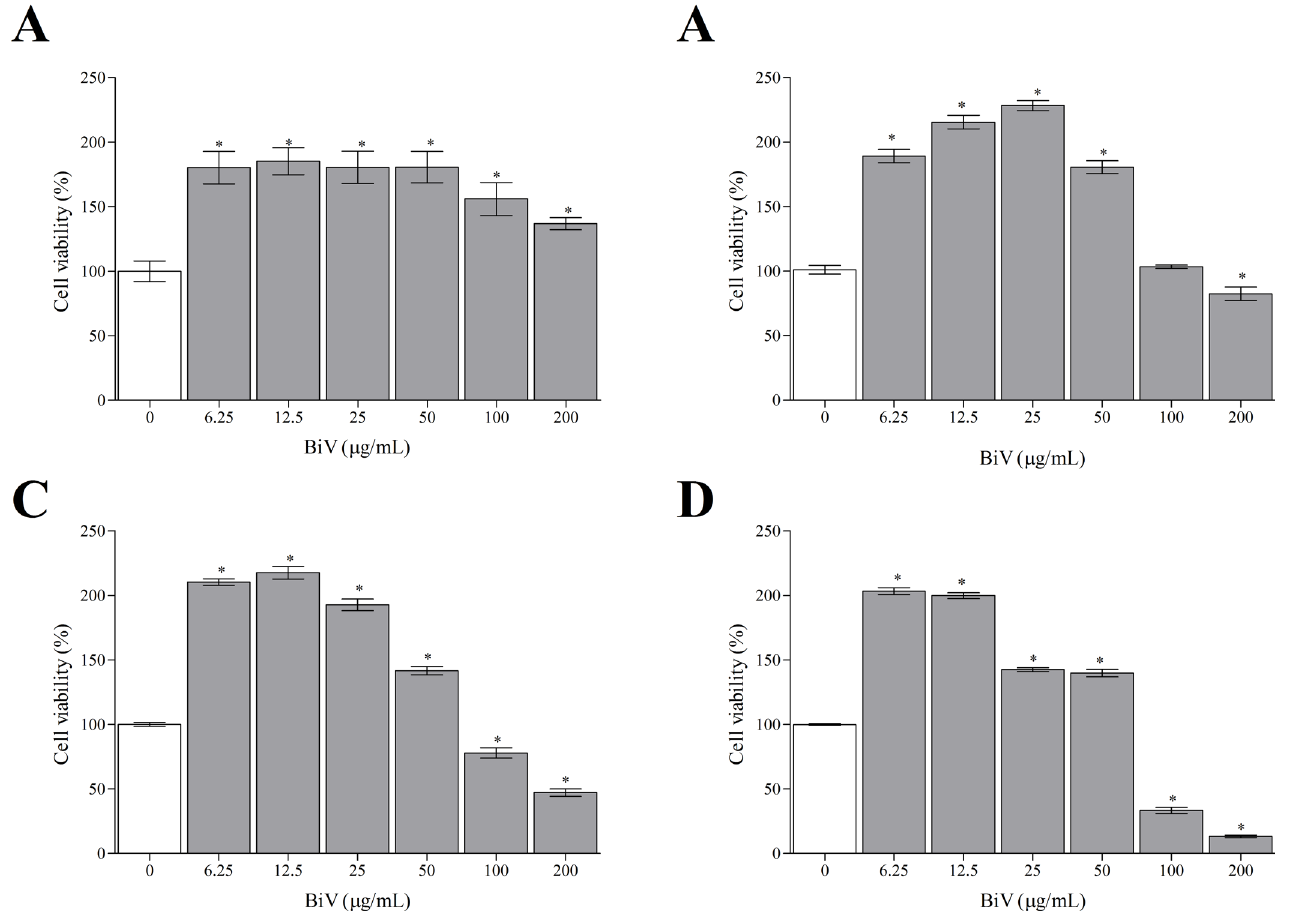
Fig 2. Time- and concentration-dependent biological effect caused by BiV on RAW 264.7 cells. Cell viability was determined after [A] 2 hours, [B] 6 hours, [C] 12 hours and [D] 24 hours of incubation with BiV, using MTT reduction assay. * p < 0.05 vs. control group.